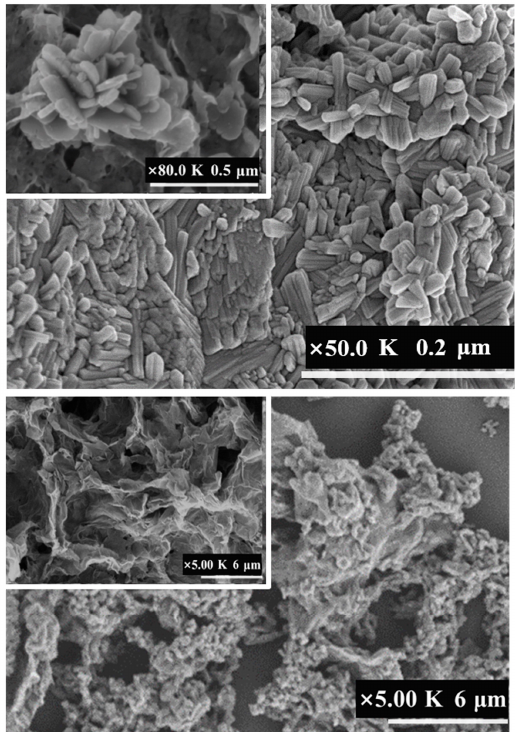
Figure 1. ( a ) Scanning electron microscope (SEM) of CuAl-LDH (×50.0 k; CuAl-LDH inset ×80.0 k) and ( b ) CuAl-LDH/Gr NCs (×5.00 k; Gr inset ×5.00 k).